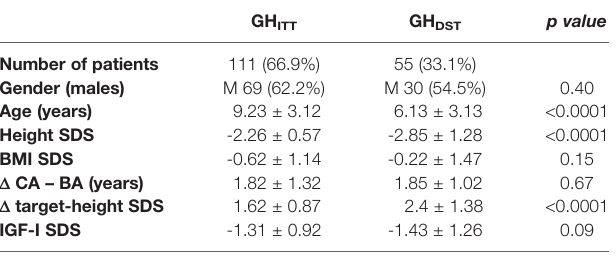
TABLE 1 | Auxological and demographic features of patients sequentially tested with AST and ITT (GH ITT ), and with AST and DST (GH DST ). GH ITT GH